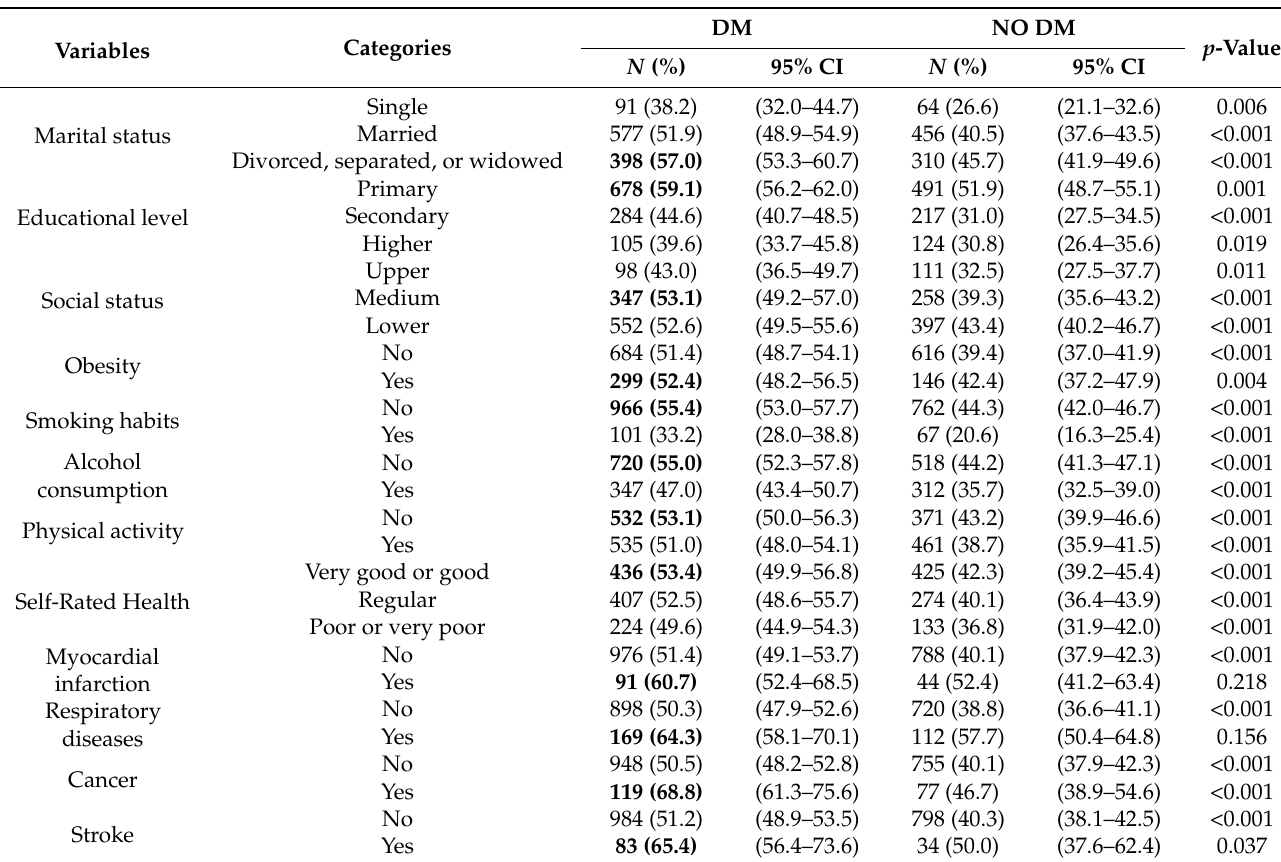
Table 2. Vaccine uptake in European Health Survey 2020 (EHS 2020).